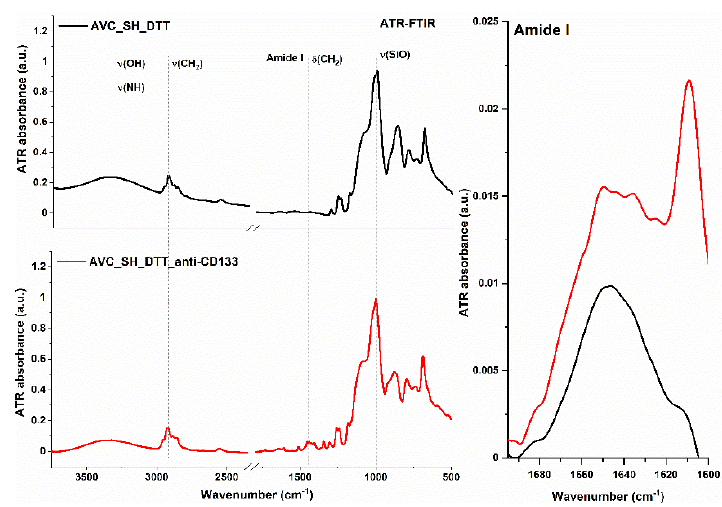
Figure 6. ATR-FTIR spectra of the AVC after mercaptosilanization and reduction before ( upper ) and after ( bottom ) deposited solution of anti-CD133 with the amide I range enlarged ( right ).